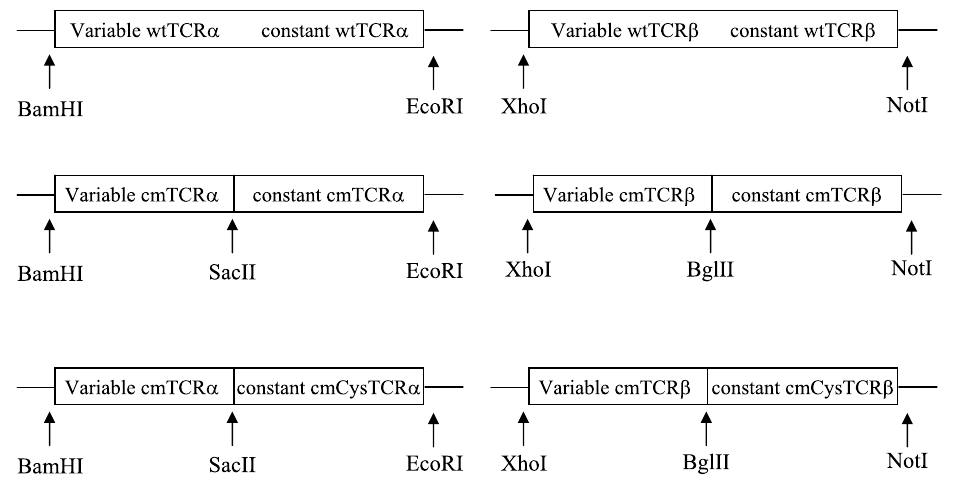
Fig. 2. Schematic representation of retroviral constructs encoding for the wt (A), cm (B) or cmCys (C) TCR α and TCR β genes. Isolated wt TCR α and wtTCR β from CTL clone 7E7 were introduced into the multiple cloning sites (mcs) of LZRS carrying the marker genes GFP and NGFR, respectively (B + C), using the indicated restriction enzymes. Variable cmTCR α and cmTCR β can be easily introduced into the pCRScript vectors containing the cm or cmCys constant domains of the TCR chains. The variable cmTCR α chain can be introduced using BamHI ∗ SacII while the cmTCR β chain can be introduced using XhoI ∗ BglII. The cm and cmCysTCR α and TCR β chains can subsequently be introduced into the mcs of LZRS-mcs-I-GFP and LZRS-mcs-I-NGFR, respectively, using BamHI ∗ EcoRI for the TCR α chain and XhoI ∗ NotI for the TCR β